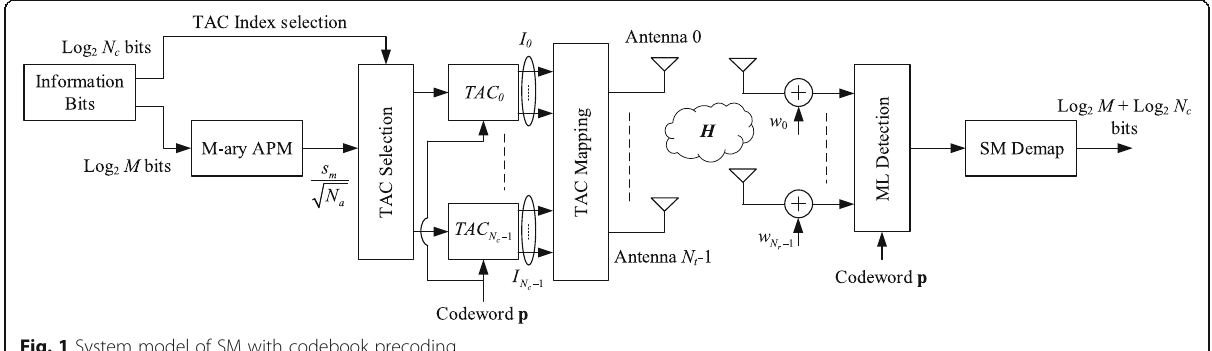
Fig. 1 System model of SM with codebook precoding